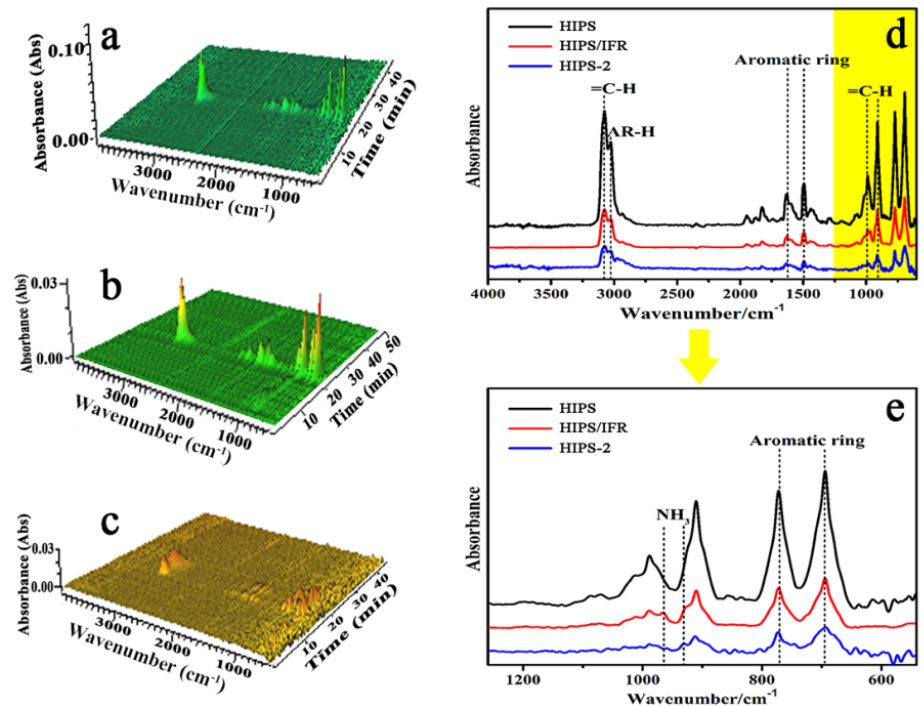
Figure 7. The TG-TR results of the HIPS compounds: ( a ) 3D TG-IR spectra of pure HIPS; ( b ) 3D TG-IR spectra of pure HIPS/IFR; ( c ) 3D TG-IR spectra of HIPS-2; ( d , e ) FTIR spectra of pyrolysis gases for pure HIPS, HIPS/IFR and HIPS-2 at the maximum decomposition rate.